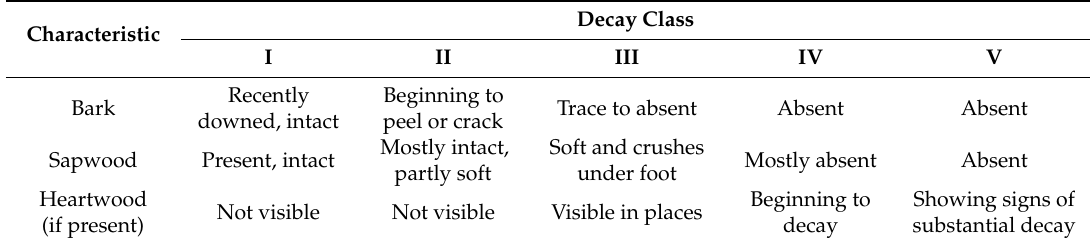
Table 3. Decay class designations for coarse woody